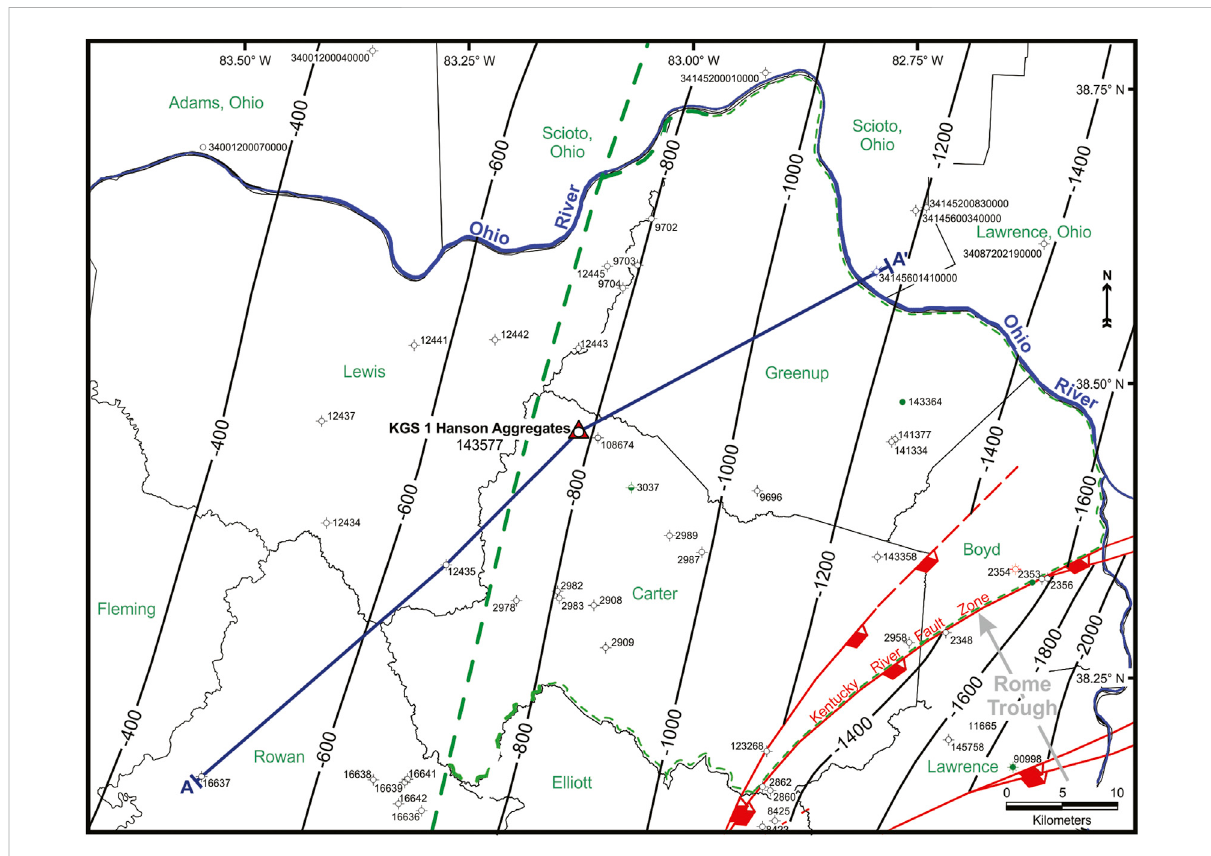
FIGURE 3 Subsurface structural contours on top of the Rose Run Sandstone show gentle dip to the east ( − 0.8 ° ) in the region northwest of the Kentucky River Fault Zone. Wells shown on this and subsequent maps are those reaching the Precambrian basement. The evaluation region is outlined by the dashed green line, and the updip limit of potential supercritical CO 2 storage is shown by the dashed green contour at -714 m subsea elevation. Contour interval is 200